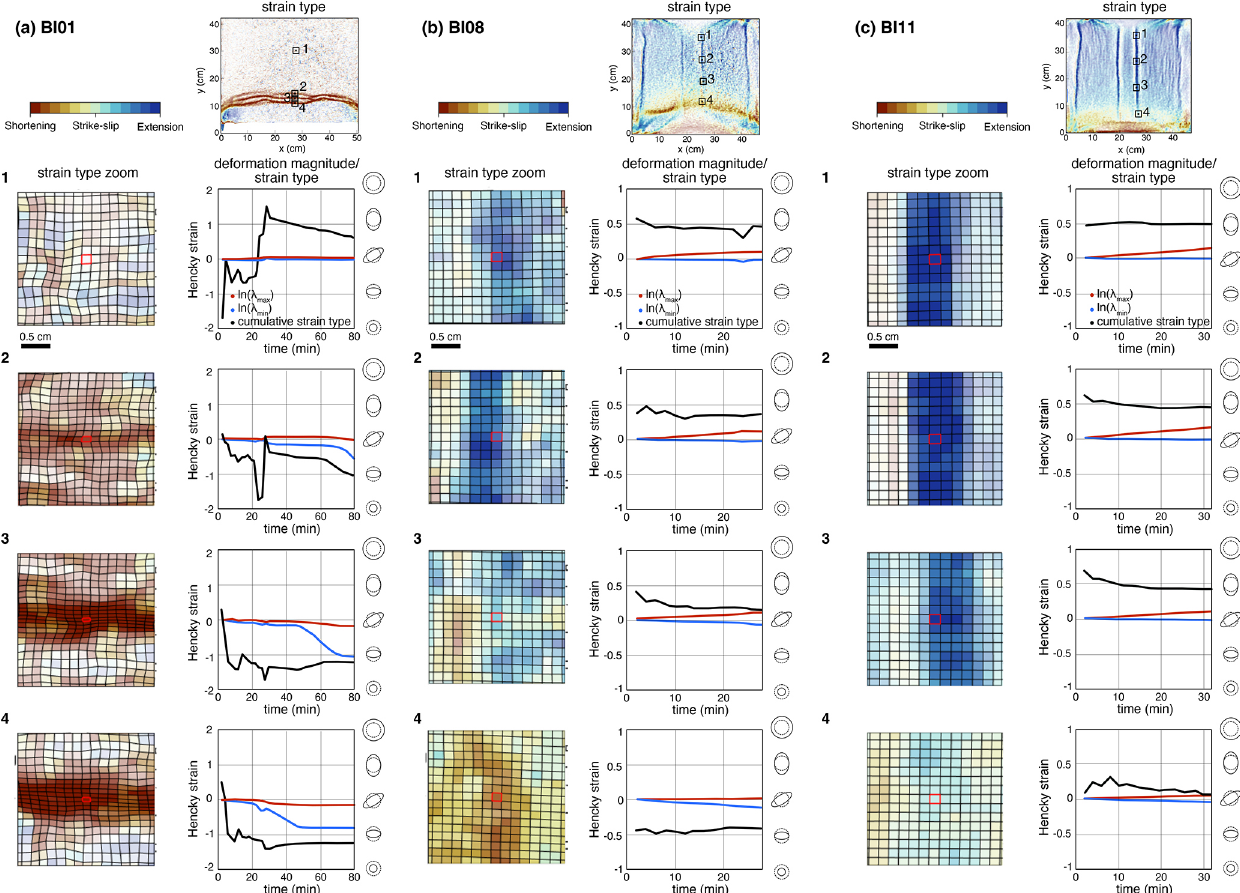
Figure 5. Temporal evolution of principal stretches and strain type during the second stage of deformation for points 1, 2, 3, and 4 in models (a) BI01, (b) BI08, and (c) BI11 (brittle crust). Upper right-hand panel: strain type (final) and overview of the selected areas. Left column: zoom on the strain type and the selected grid cell (which is outlined in red, with neighboring cells outlined in black). Right column: time evolution of the logarithm of the two principal stretches (Hencky strain; blue and red curves) and associated strain type (cumulative; black curve, right